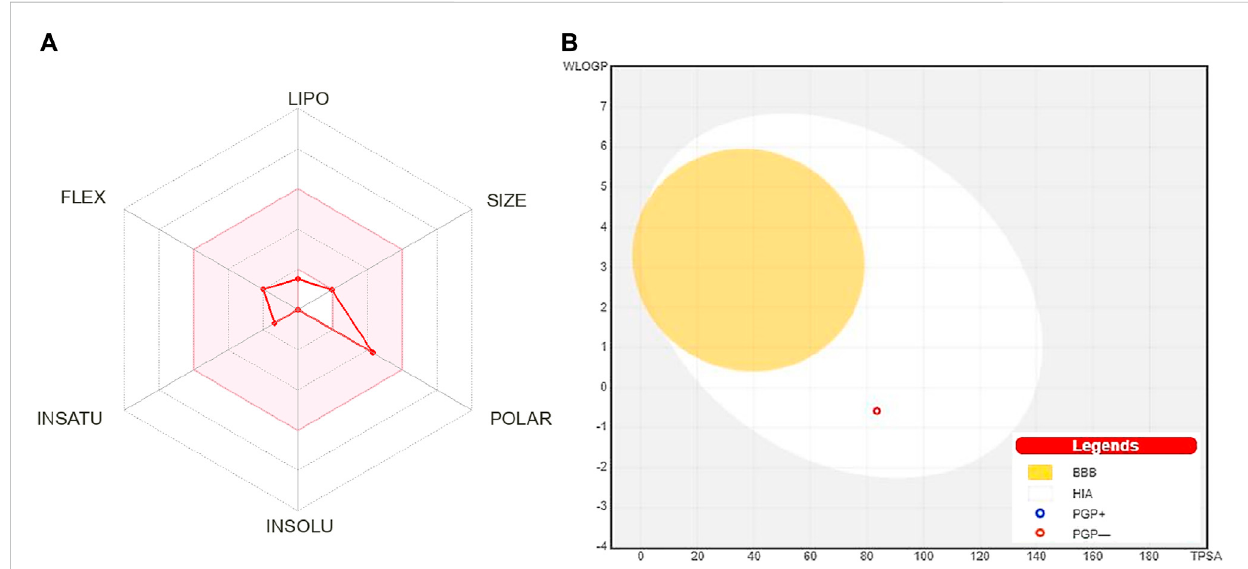
FIGURE 1 (A) Oral bioavailability graph from the SwissADME database; the pink zone is the physicochemical space for oral bioavailability, and the red line de fi nes oral bioavailability properties of 4-hydroxyisoleucine. (B) Predicted boiled-egg plot from the SwissADME database reveals human intestinal absorption and not being Pgp substrate. LIPO: lipophilicity, POLAR: polarity, INSOLU: insolubility, INSATU: unsaturation, FLEX: fl exibility, BBB: blood – brain barrier, HIA: human intestinal absorption, PGP+: p-glycoprotein substrate, and PGP-: not a p-glycoprotein substrate.